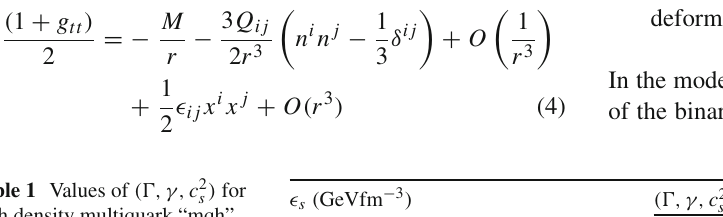
Table 1 Values of ((cid:5),γ, c 2 s ) for high density multiquark “mqh” in the inner core and low density “mql” in the outer core with CET/FYSS nuclear crust at the maximum mass of the massive NS with MQ core